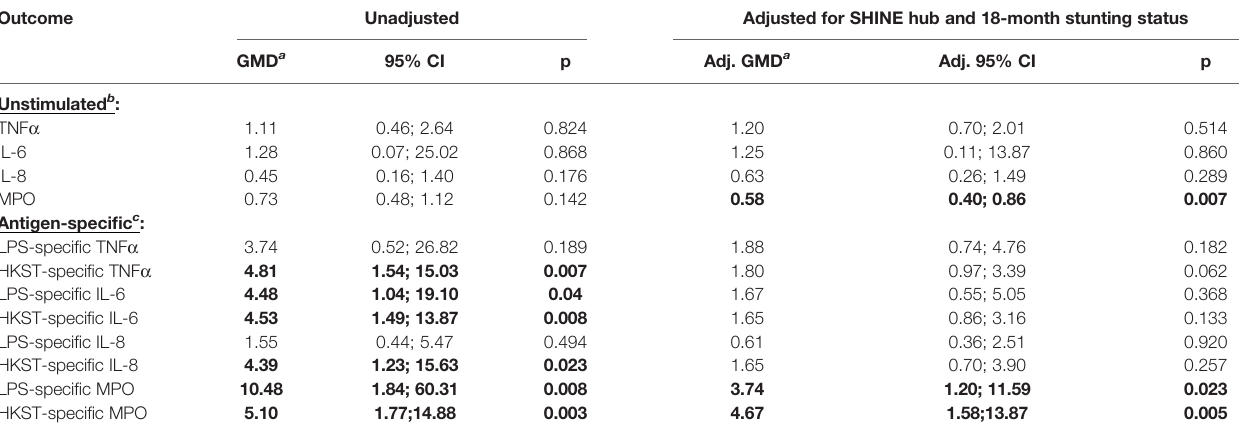
TABLE 4 | Censored log-normal (tobit) regression analysis of the relationship between WASH intervention arm and immune-mediator production at 18 months of age. Outcome Unadjusted Adjusted for SHINE hub and 18-month stunting status GMD a 95% CI p Adj. GMD a Adj. 95%